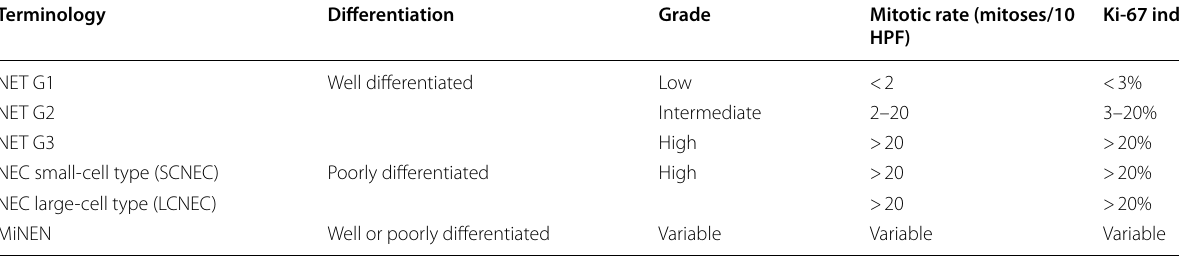
Table 2 Classification and grading criteria for NEN (2019) [8]